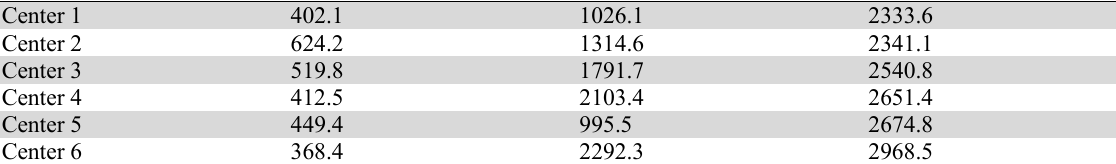
Centers obtained for the best OFV on vowel data set